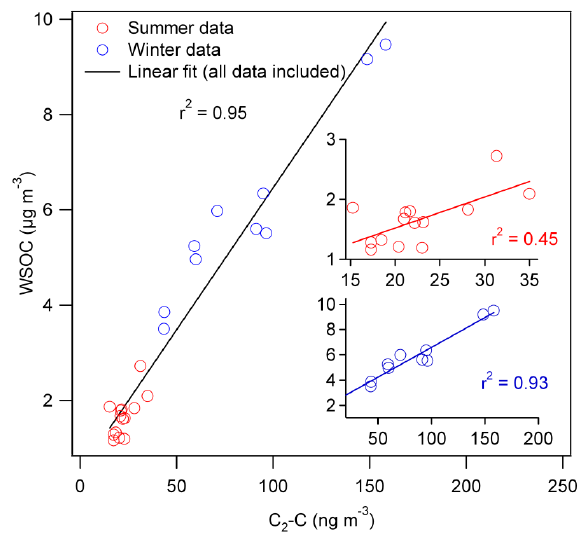
Fig. 10. Relation between WSOC and oxalic acid (C 2 diacid) con- centrations determined in the Mumbai aerosols in summer and win- ter (inset figures represent the relation for summer and winter data